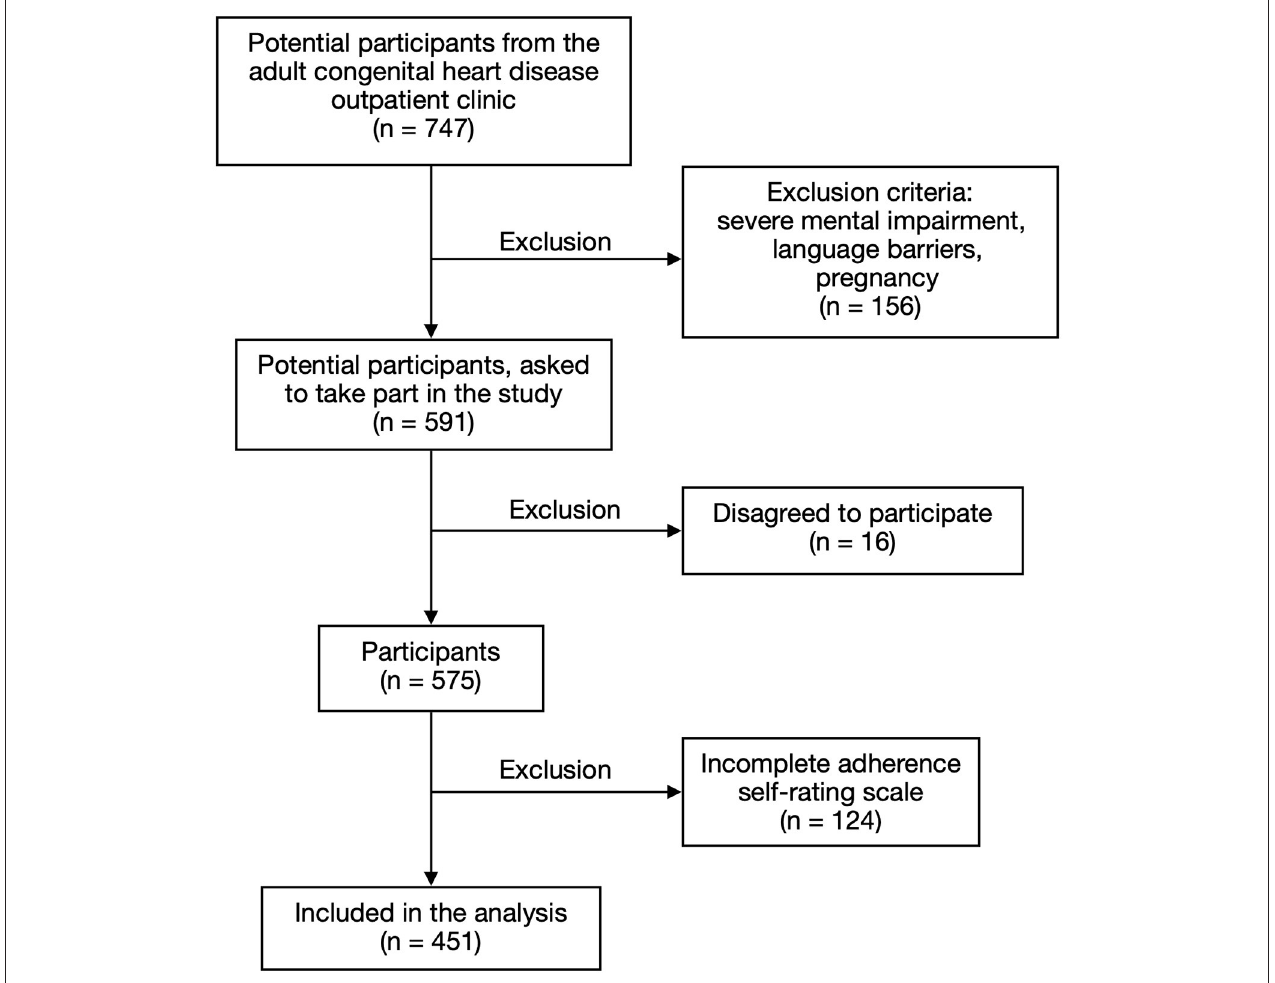
FIGURE 1 | Participant’s